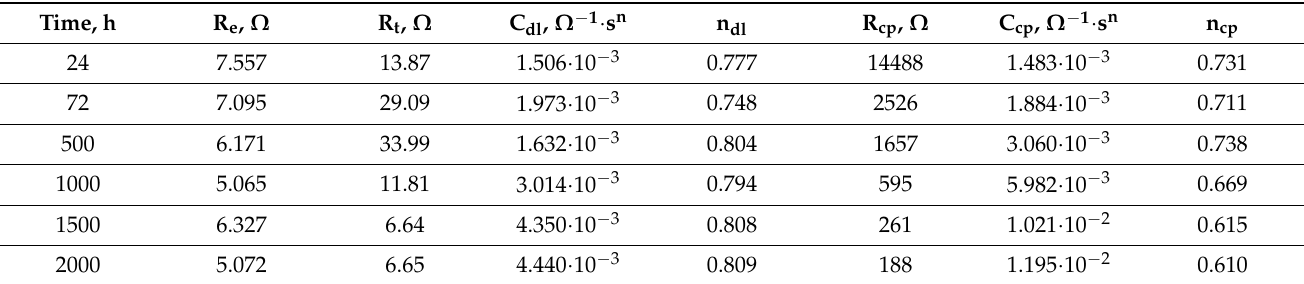
Table 2. Values of each of the equivalent circuit elements in compliance for each testing time with the protective layer model.